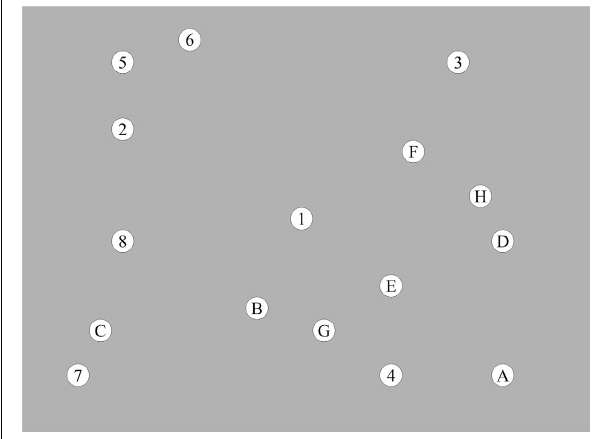
FIGURE 1 | Example of a number and letter search task stimulus